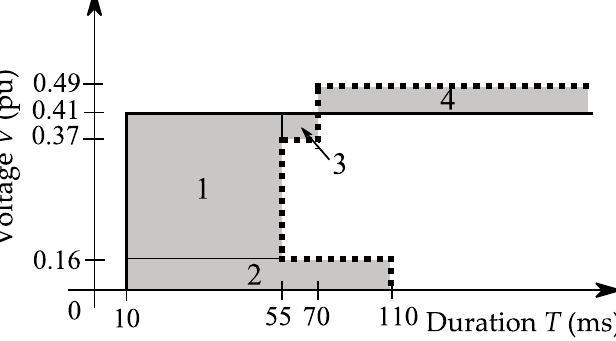
Figure 8. Individual sub-region thresholds for contactors.